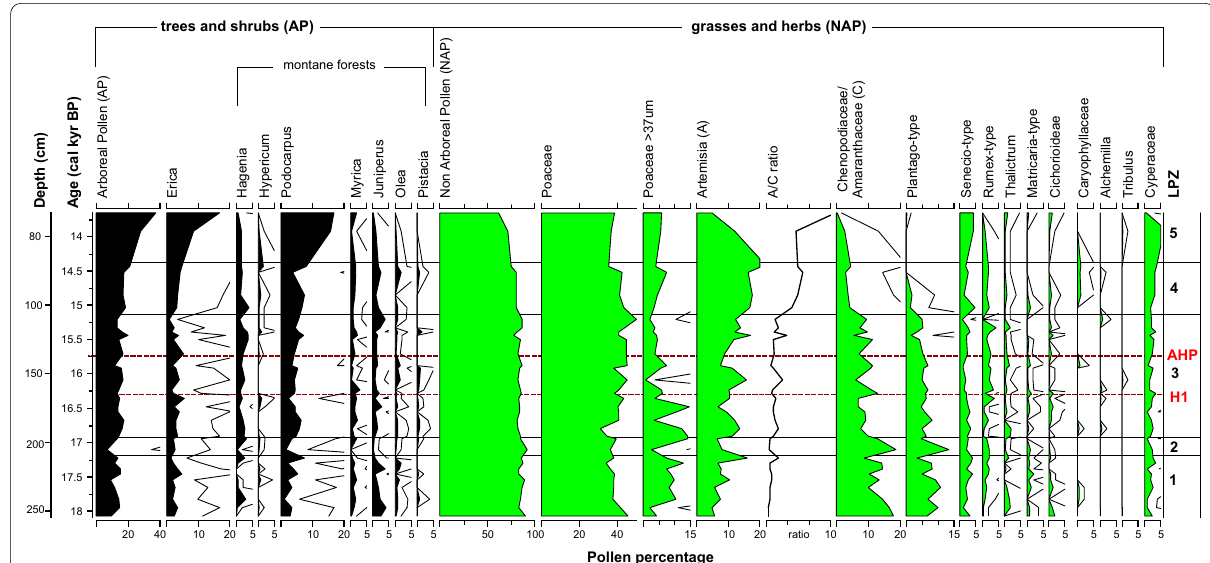
Fig. 6 Percentage diagram of selected pollen taxa referring to the counting sum of pollen grains of a sample and fivefold exaggeration